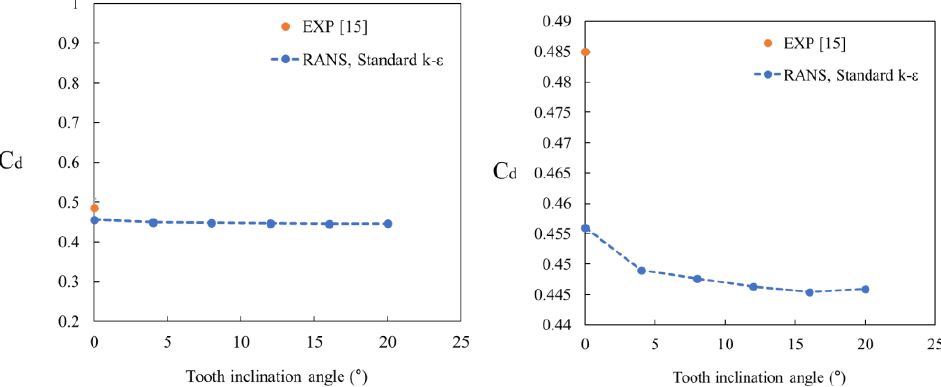
Figure 10. The effect of varying the tooth inclination angle on the discharge coefficient of the labyrinth seal under a pressure ratio of 2. The y-axis units on the right-hand side plot have been expanded. C d —discharge coefficient.